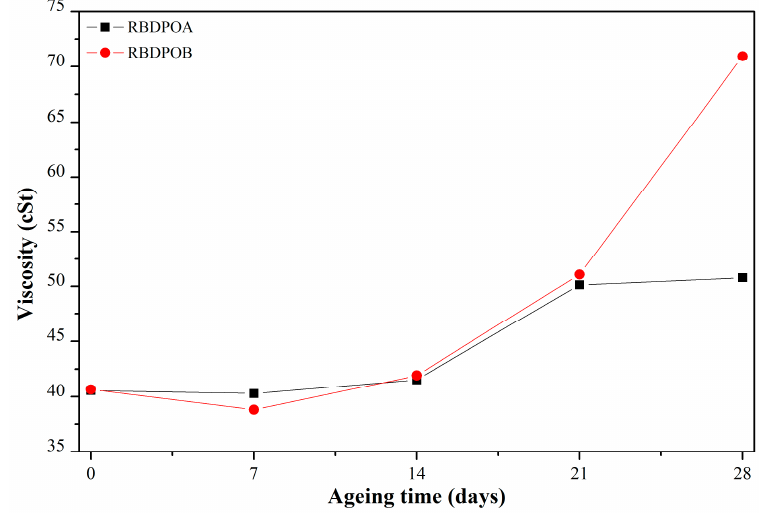
Figure 3. Viscosity of RBDPO aged at 170 °C under open conditions.